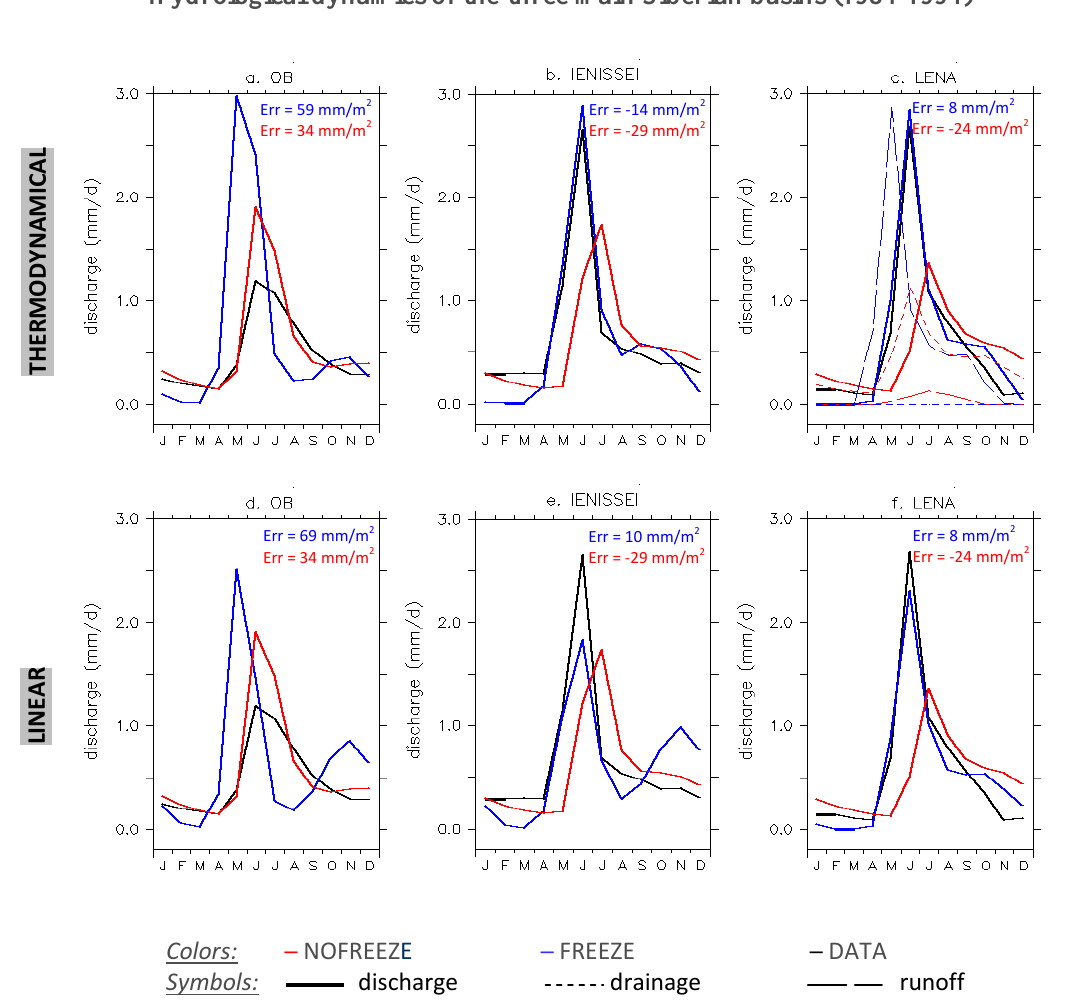
Fig. 11. Mean annual hydrological dynamics of the three main Siberian basins, as simulated with (FREEZE) and without (NOFREEZE) the new soil freezing scheme for the decade 1984–1994, and river discharges from the R-ArcticNET database (DATA). In the upper part the soil freezing scheme uses the thermodynamical parameterization; in the lower part the linear parameterization is used. Plain curves represent the hydrographs at the mouth of the rivers; thin dotted lines and large dotted lines represent drainage at the bottom of the soil column and surface runoff, respectively (only shown for the Lena basin in the upper part of the figure). “Err” refers to the mean model error in the cumulated annual discharge over the